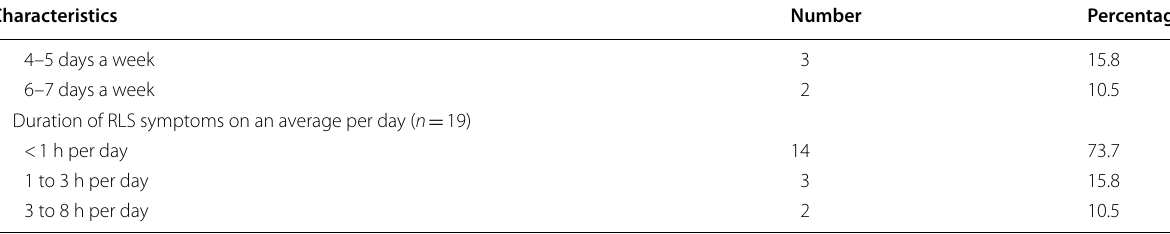
Table 3 Association between various determinants and restless leg syndrome status among the participants ( n